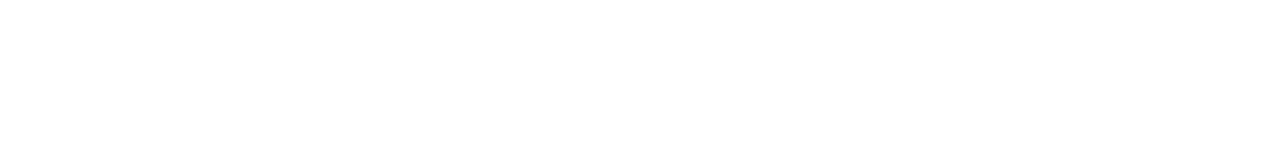
Frontiers in Environmental Chemistry |